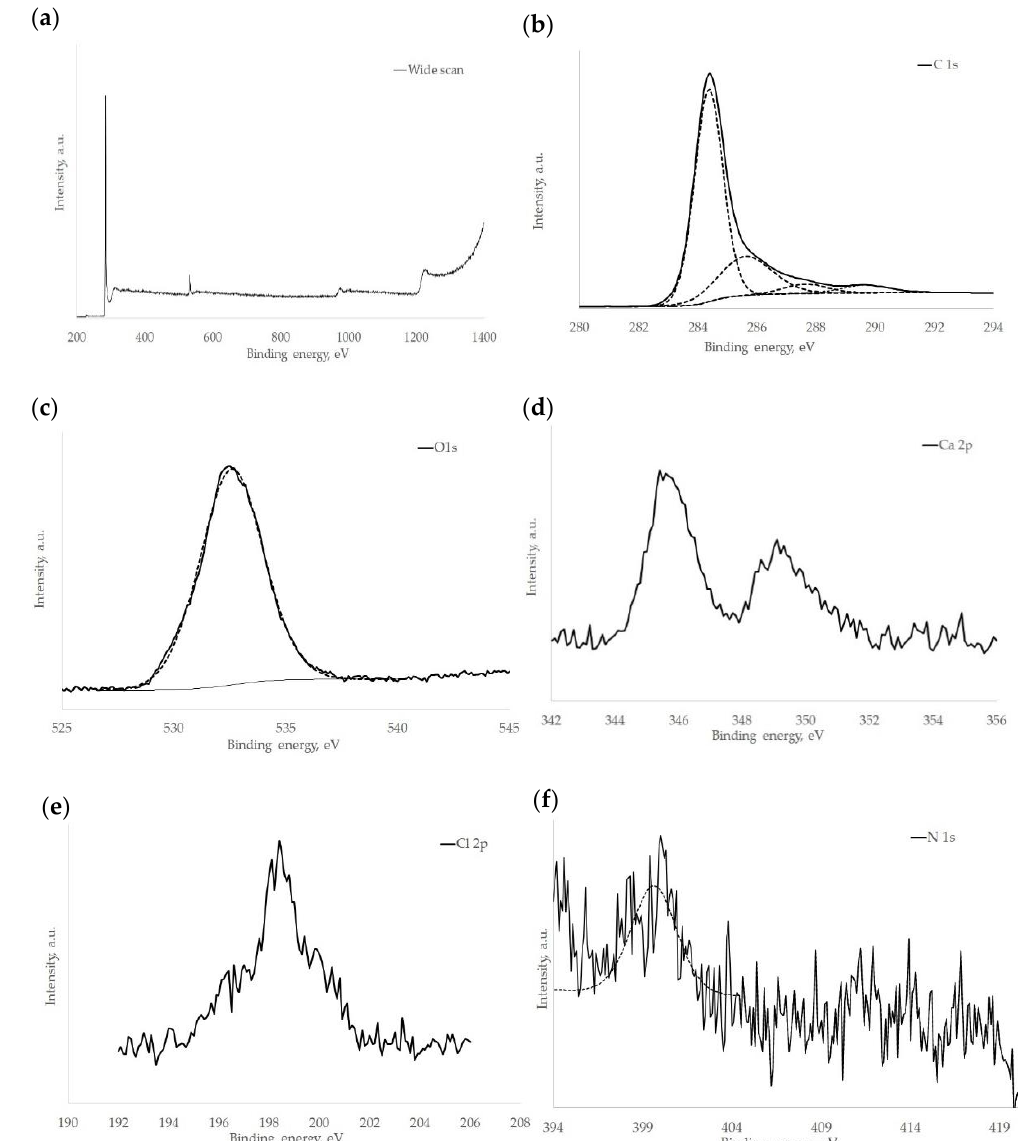
Figure 3. Results of XPS analysis: ( a ) wide scan, binding energies of: ( b ) carbon, ( c ) oxygen, ( d ) chromium, ( e ) calcium, ( f ) nitrogen.